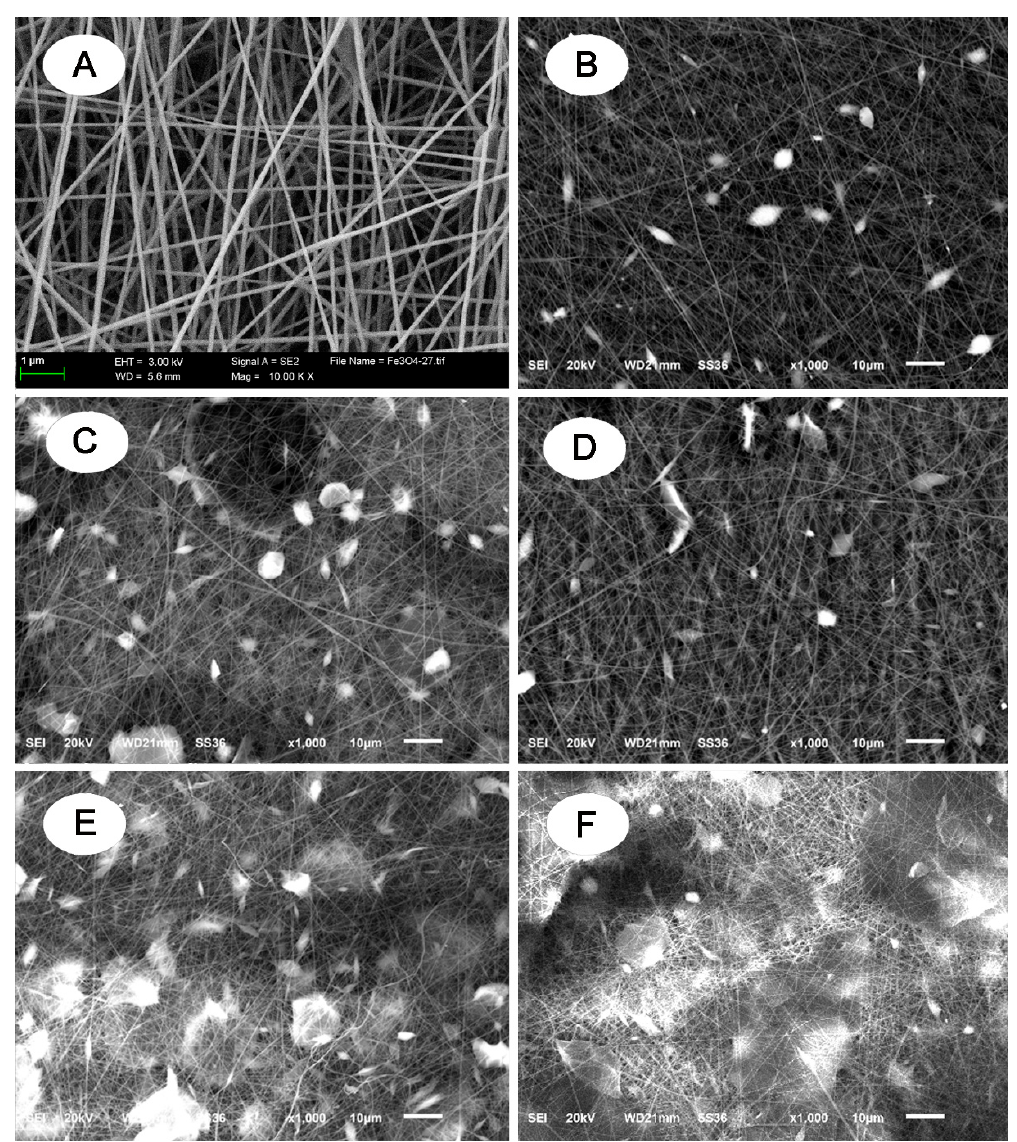
Figure 2. SEM images of ( A ) PAN, ( B ) PAN/DCDMH, ( C ) PAN/GO, ( D ) PAN/GO 0.05 /DCDMH, ( E ) PAN/GO 0.1 /DCDMH, and ( F ) PAN/GO 0.15 /DCDMH.